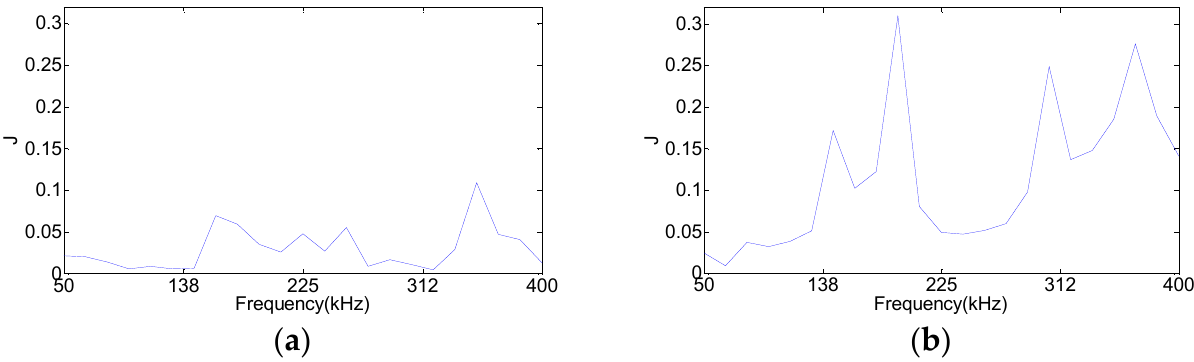
Figure 8. Scatter index J for tool condition change with ( a ) signals on spindle; ( b ) signals on workpiece.